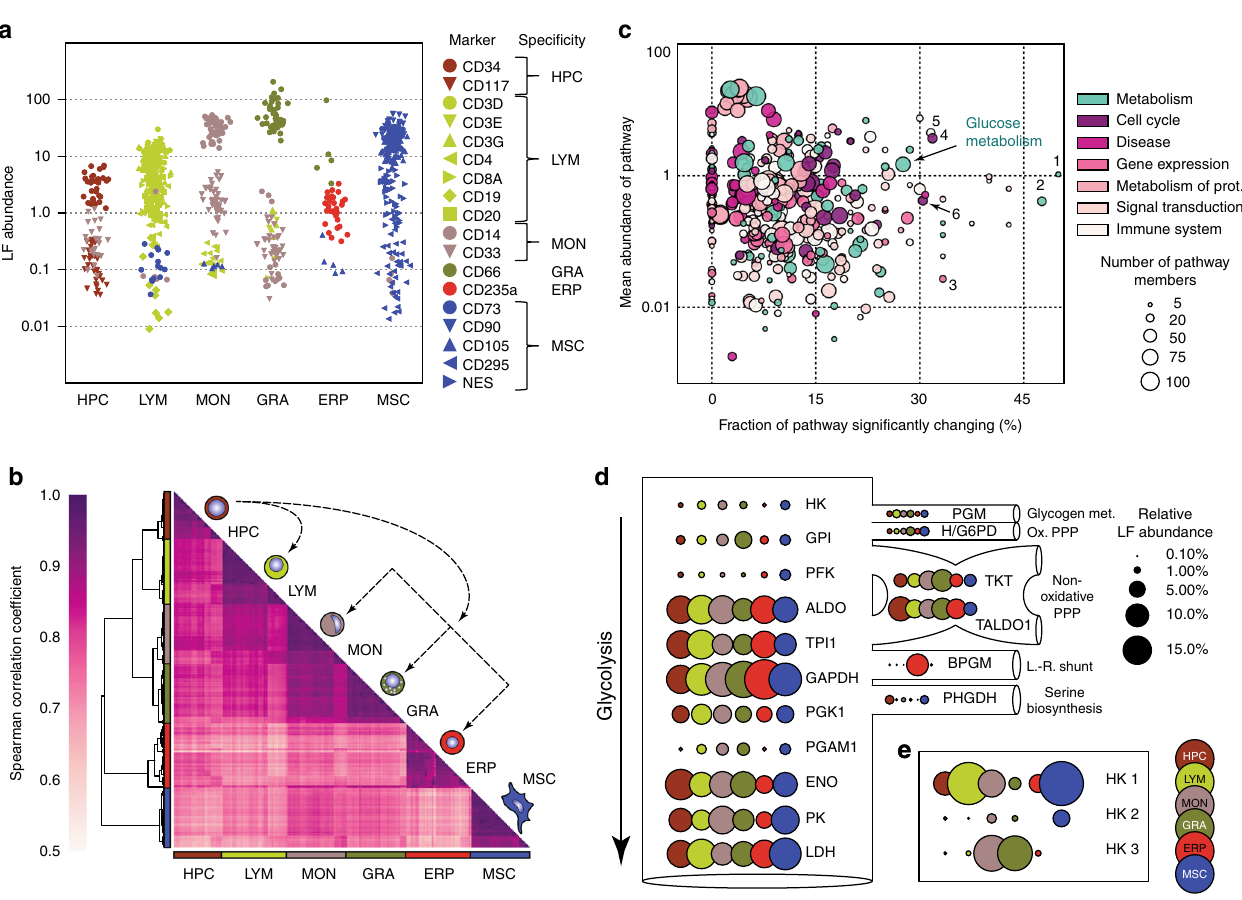
Fig. 2 Quality of the dataset and differences between the cell populations. a Jitter plot displaying the relative label-free (LF) abundance of established cell type-speci fi c markers. Each symbol represents an individual sample. b Correlation matrix of Spearman ’ s rank correlation coef fi cients between all 270 samples and depiction of the haematopoietic subpopulations examined. The correlation coef fi cient was calculated based on the LF abundances of proteins covered in ≥ 85% of the samples of each cell population (950 proteins). Characteristic proteome clusters were identi fi ed in samples derived from the same cell population. c Bird ’ s-eye view on pathways with different stoichiometry in the different cell populations. The fraction of a pathway that changed signi fi cantly between at least two cell types ( x -axis) is plotted against the mean label-free (LF) abundance of an entire pathway across the different cell populations. The circles in the scatter plot signify Reactome pathways and their size corresponds to the number of quanti fi ed proteins per pathway. The colour refers to the highest hierarchy of the particular pathway according to Reactome. The highest hierarchies were fi ltered to have at least 30 pathways quanti fi ed in the dataset with each containing 5 – 100 protein members. The numbers indicate the following pathways; 1 ethanol/oxidation; 2 Histidine/Lysine/Phenylalanine/Tyrosine/Proline/Tryptophan catabolism; 3 RNA polymerase II transcription termination; 4 DNA replication pre-initiation; 5 endoplasmic reticulum-phagosome pathway; 6 activation of ATR in response to replication stress. d The glycolytic pathway and branching points to connected pathways, e.g., the oxidative pentose phosphate pathway (Ox. PPP) or the Luebering – Rapoport shunt (L.-R. shunt), are depicted. Each bubble represents an enzyme with the area of the bubble encoding for the cell type-speci fi c, relative LF abundance with 100% representing the sum of all proteins per cell population depicted in d . The colour codes for the cell population as depicted in the lower right corner. e Relative abundances of the hexokinase isoenzymes in the respective subpopulations are shown analogous to d , but fi vefold enlarged to better illustrate the